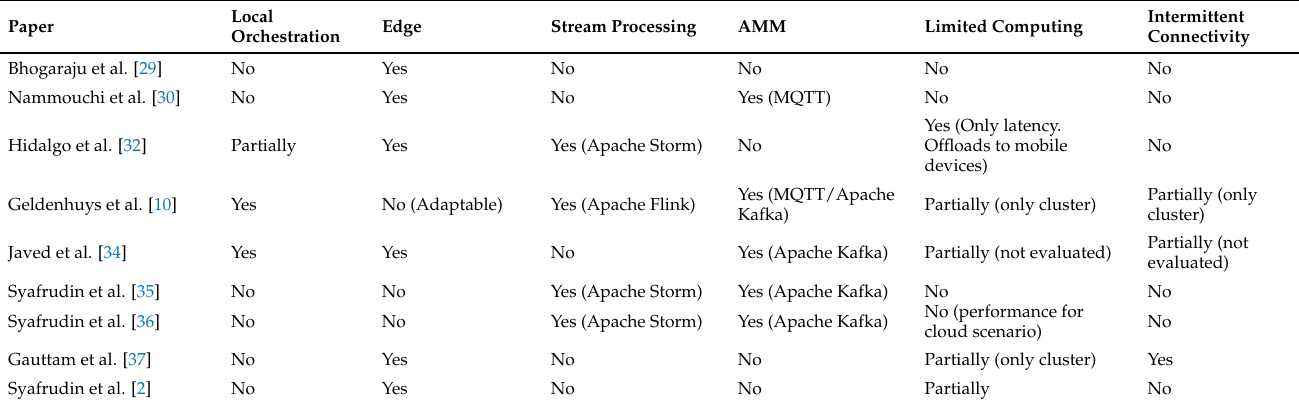
Table 1. A summary of papers that were considered in the Related Work